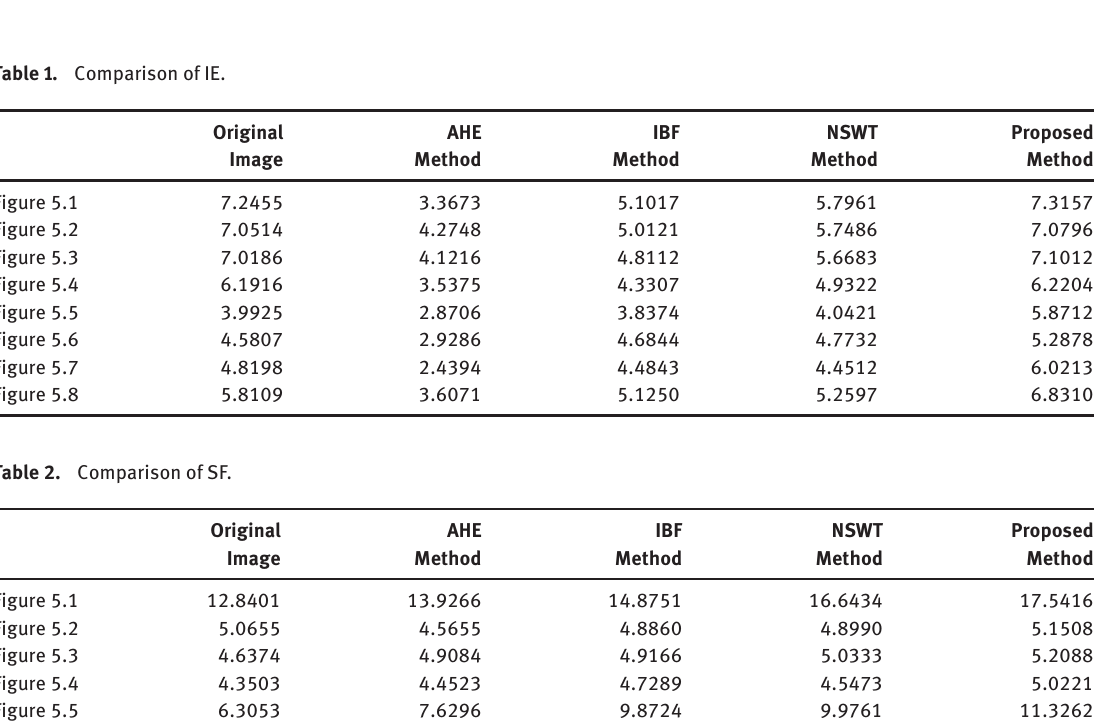
Figure 5.1 Figure 5.2 Figure 5.3 Figure 5.4 Figure 5.5 Figure 5.6 Figure 5.7 Figure